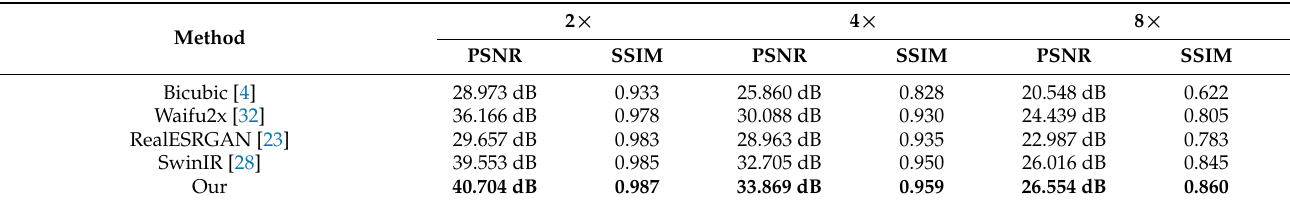
Table 3. Comparison with other super-resolution methods on AnimeFace180 test dataset (180 images). The final result is the average result of 180 test images in the Animeface180 test dataset (best results are indicated with bold). N =